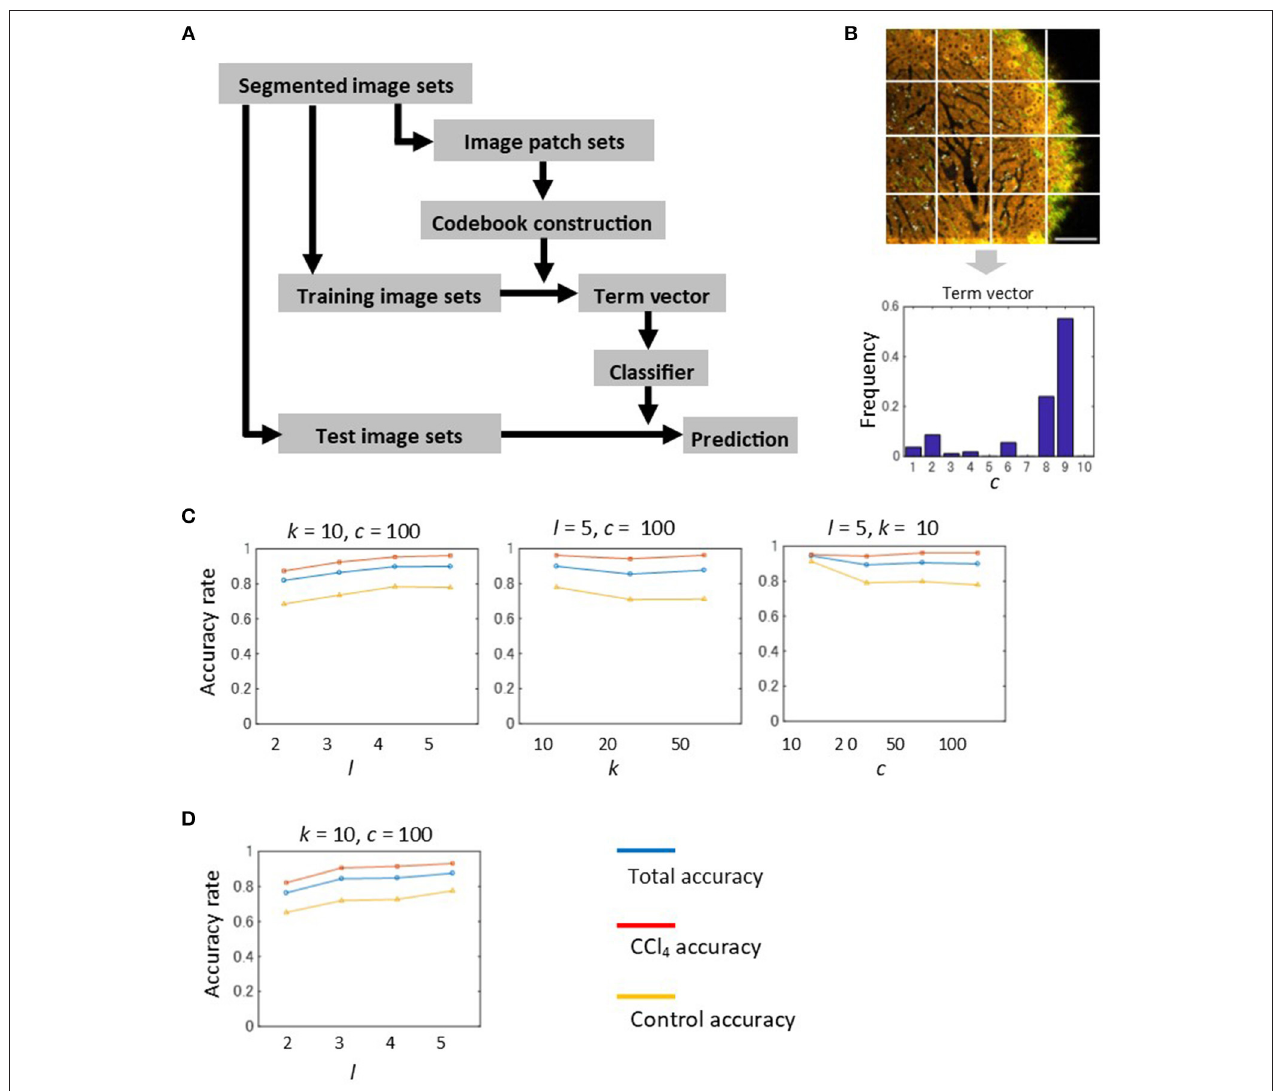
FIGURE 5 | Automated image classification test by the BoF machine learning method. (A) Procedure of the BoF framework. BoF is comprised of three steps, codebook construction, training, and testing. In the codebook construction step, image patch sets were created and feature vectors corresponding to the image patches were calculated. The feature vectors were defined as histograms of spectral markers collected within image patches. Visual words, which comprise the codebook, were created from these vectors by performing vector quantization. In the training step, an image was represented as a set of image patches that are subjected to feature vector calculations and visual word assignments. A histogram of visual word occurrences (term vector) was subsequently calculated for each image. Based on these data, the SVM classifier was constructed. In the test step, image prediction was performed based on the classifier. (B) Term vector calculation for an image. A divided image using the regular square grid with the division level l = 2 was shown. An image which is represented as a set of visual words was converted to a term vector. (C) Results of the classification test performed on 2-weeks models. The machine learning parameters are the division level l , the cluster number of the spectral markers k , and the codebook size c . The total, CCl 4 , and control accuracy rates are depicted as blue, red, and yellow lines, respectively. (D) Results of the classification test performed on 2-weeks models excluding SHG marker information. The total, CCl 4 , and control accuracy rates are depicted as blue, red, and yellow lines,